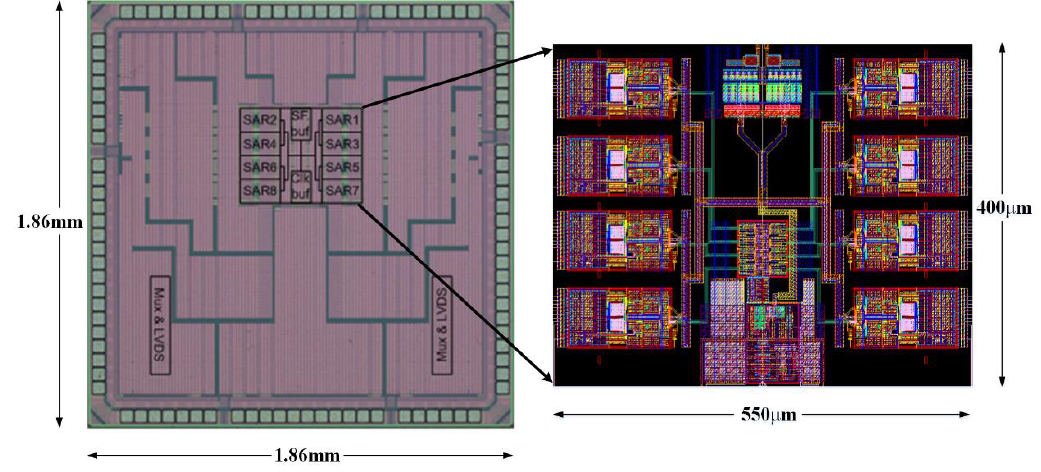
Figure 7. Die micrograph with layout view.